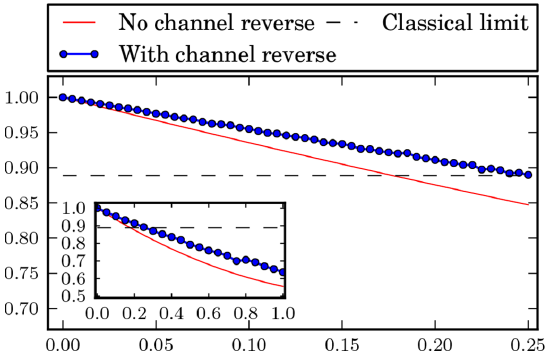
Figure 6. Phase damping channel. Probability of winning the pseudo-telepathy game with and without the use of our approach as a function of the noise parameter a for the phase damping channel. The inset shows the probability of winning for a M [0; 1].